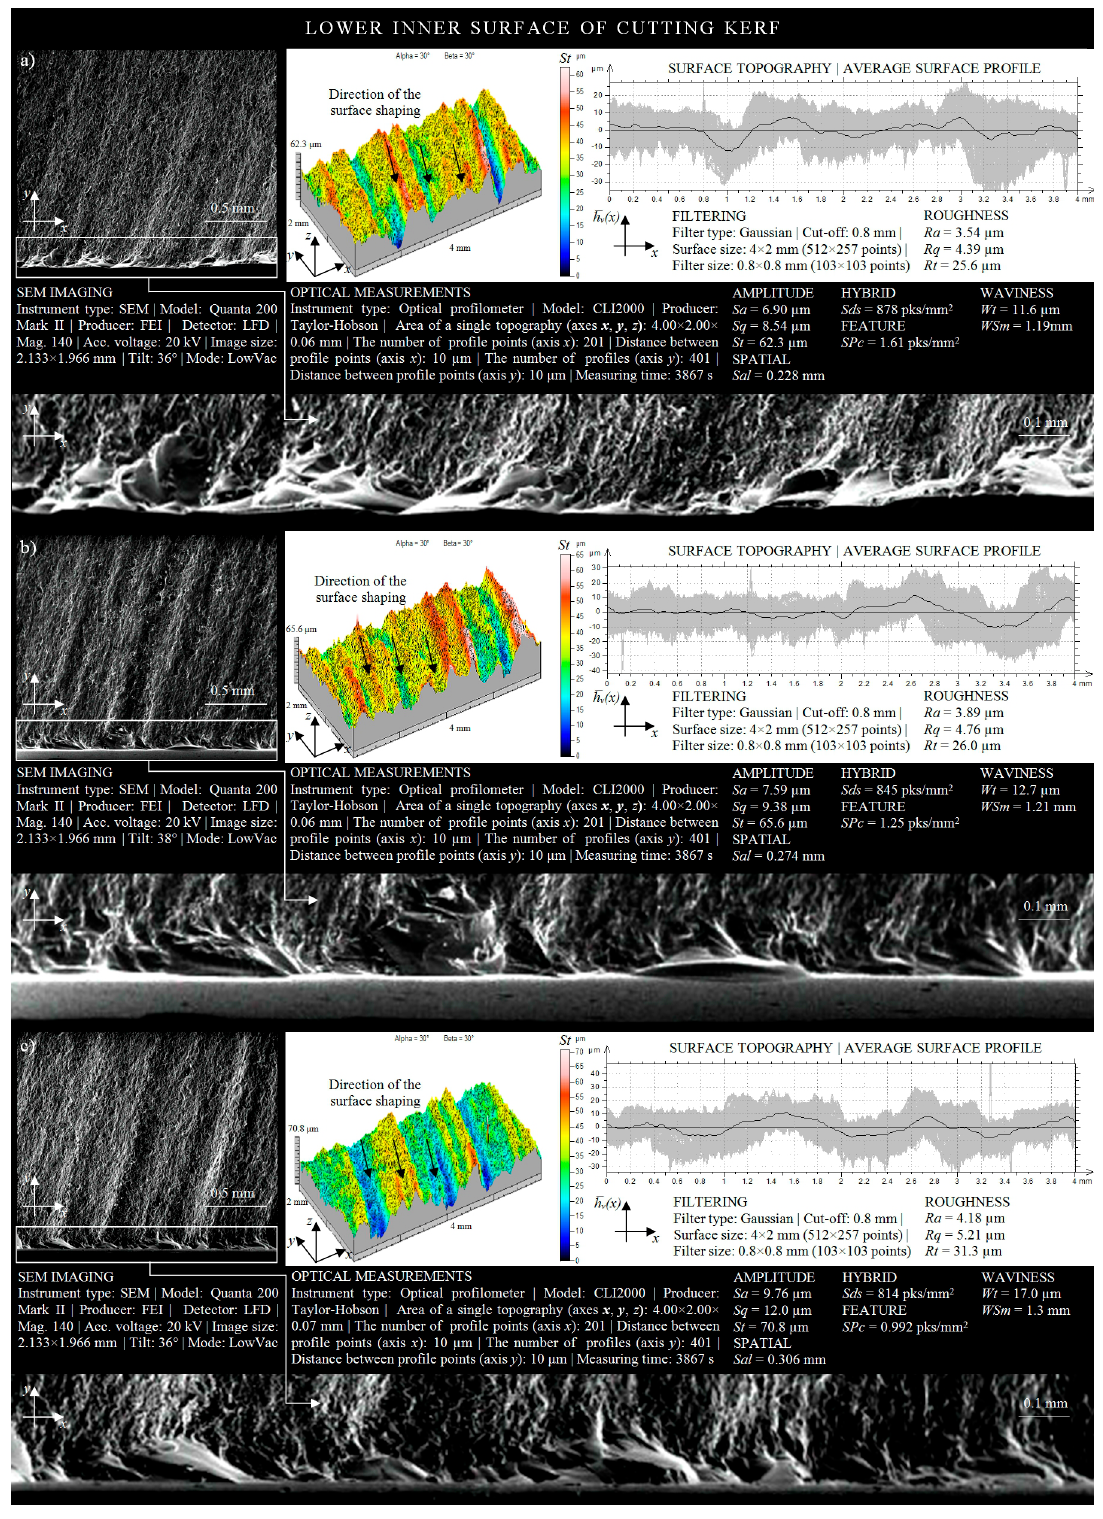
Figure 7. Collection of selected results of experimental studies obtained for the lower IS in a situation where the AWJ entered the sample surface ( l = 1.5 mm, d o = 0.38 mm, d f = 0.76 mm, m a = 0.336 kg / min, v = 427 mm / min, p = 360 MPa, g = 8 mm): ( a ) r = 50 mm; ( b ) r = 35 mm; ( c ) r = 15 mm. Changing the radius from r = 50 mm to r = 15 mm, while maintaining the remaining parameters of the cutting process at a constant level, caused an increase in the height of irregularities (given by